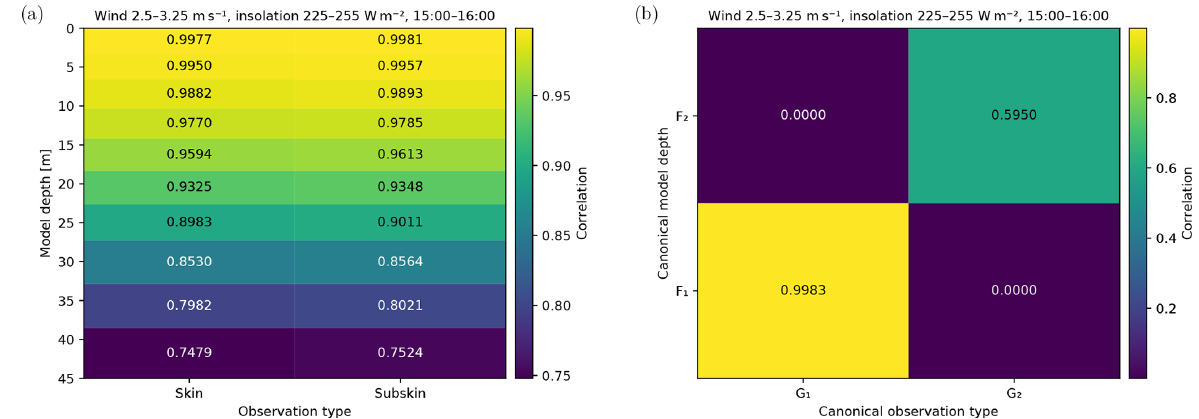
Figure 2. The correlation coefficients between the model variables and observations (a) , with the canonical equivalent of these variables (b)